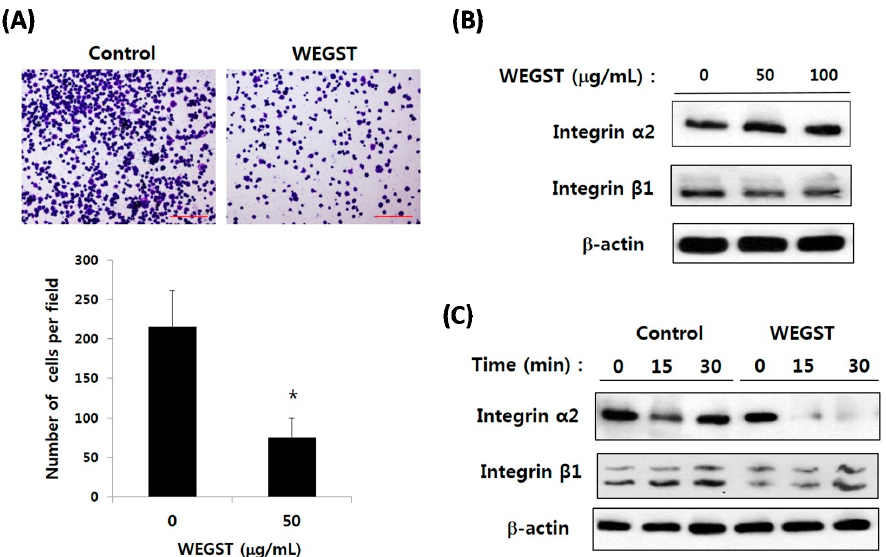
Figure 3. WEGST treatment attenuated the cell adhesion and the expression of α 2 integrin; the inhibitory effect of WEGST on PC3 cell migration was investigated. A representative figure of three independent experiments is exhibited in the upper panels. The number of attached cells was counted in four different fields and tabulated in the bottom panel ( A ); Semi-confluent PC3 cells were treated with WEGST; and the expression of α 2 and β 1 integrin was examined by western blotting ( B ); PC3 cells were pre-treated with WEGST and seeded on a collagen-coated plate. PC3 cells were harvested at various times, as indicated, and the expression of α 2 and β 1 integrin was examined by western blotting ( C ). The results shown are representative of at least three independent experiments. Error bars refer to the SD of the mean. Bar = 0.2 µm. * p < 0.05, compared with control (non-treated).